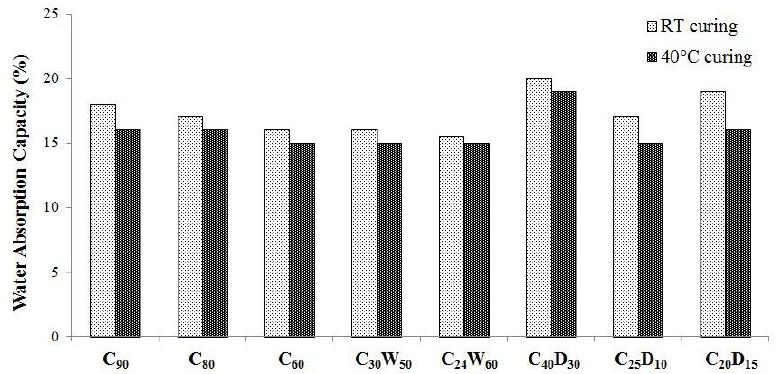
Figure 9. Water absorption capacity of artificial